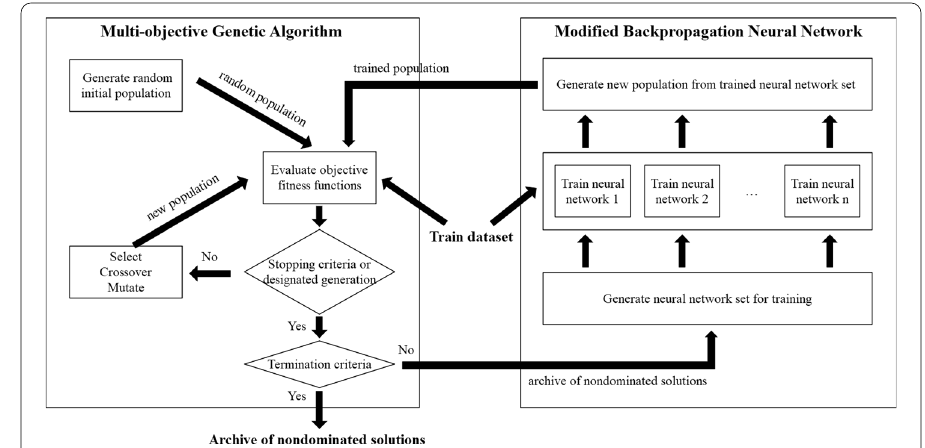
Fig. 1 Training session of the proposed